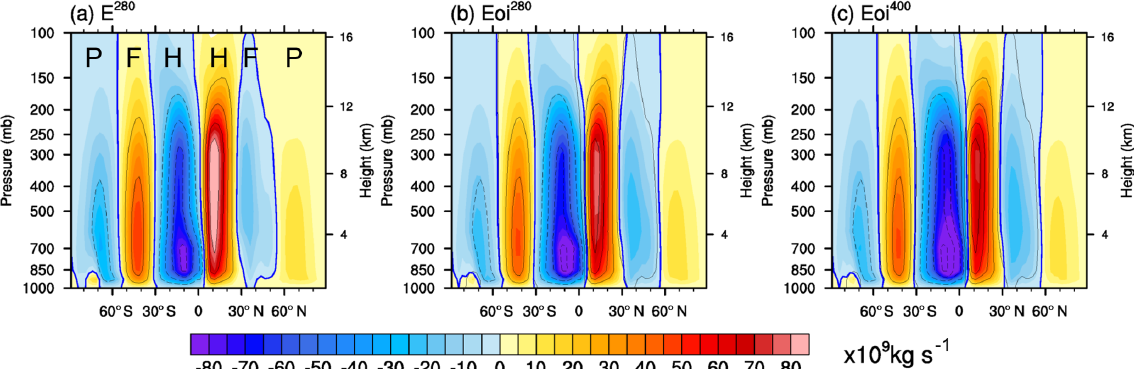
Figure 7. Mean annual zonally averaged meridional mass transport streamfunction for (a) E 280 , (b) Eoi 280 and (c) Eoi 400 . The contour lines are from E 280 and are shown for intervals of 2 × 10 10 kgs − 1 with dashed lines indicating anticlockwise (looking westward) circulation (ascending air moves southward). The solid blue contour indicates zero meridional streamfunction indicative of the boundary of circulation cells. The Hadley (H), Ferrel (F) and the polar (P) cells are indicated within panel (a) . Table 6. Global mean annual sea surface temperature (MASST) and various metrics for the spatial extent of the equatorial warm pool regions. ID MASST GWP WHWP max IPWP max (year round) ( ◦ C) ( × 10 6 km 2 ) ( × 10 6 km 2 ) ( × 10 6 km 2 ) Eoi 450 20 . 3 ± 0 . 1 107 . 5 ± 2 .